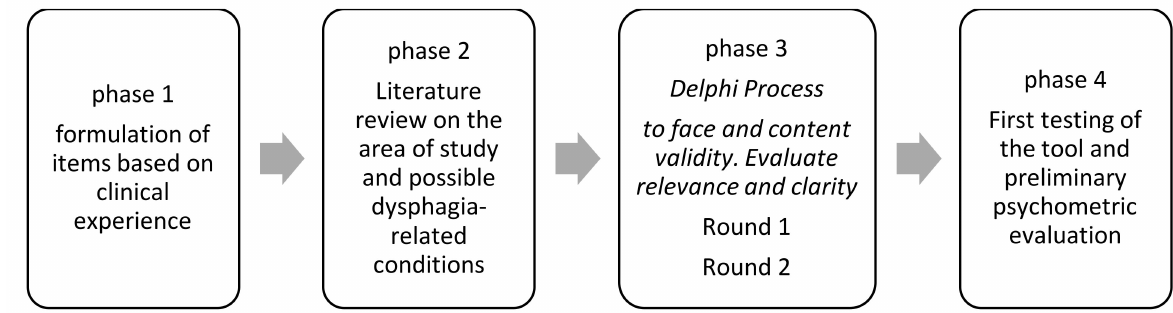
Figure 1. Flow diagram of the development of the components of a PS–PED screening tool. Table 1. Electronic Databases and Search